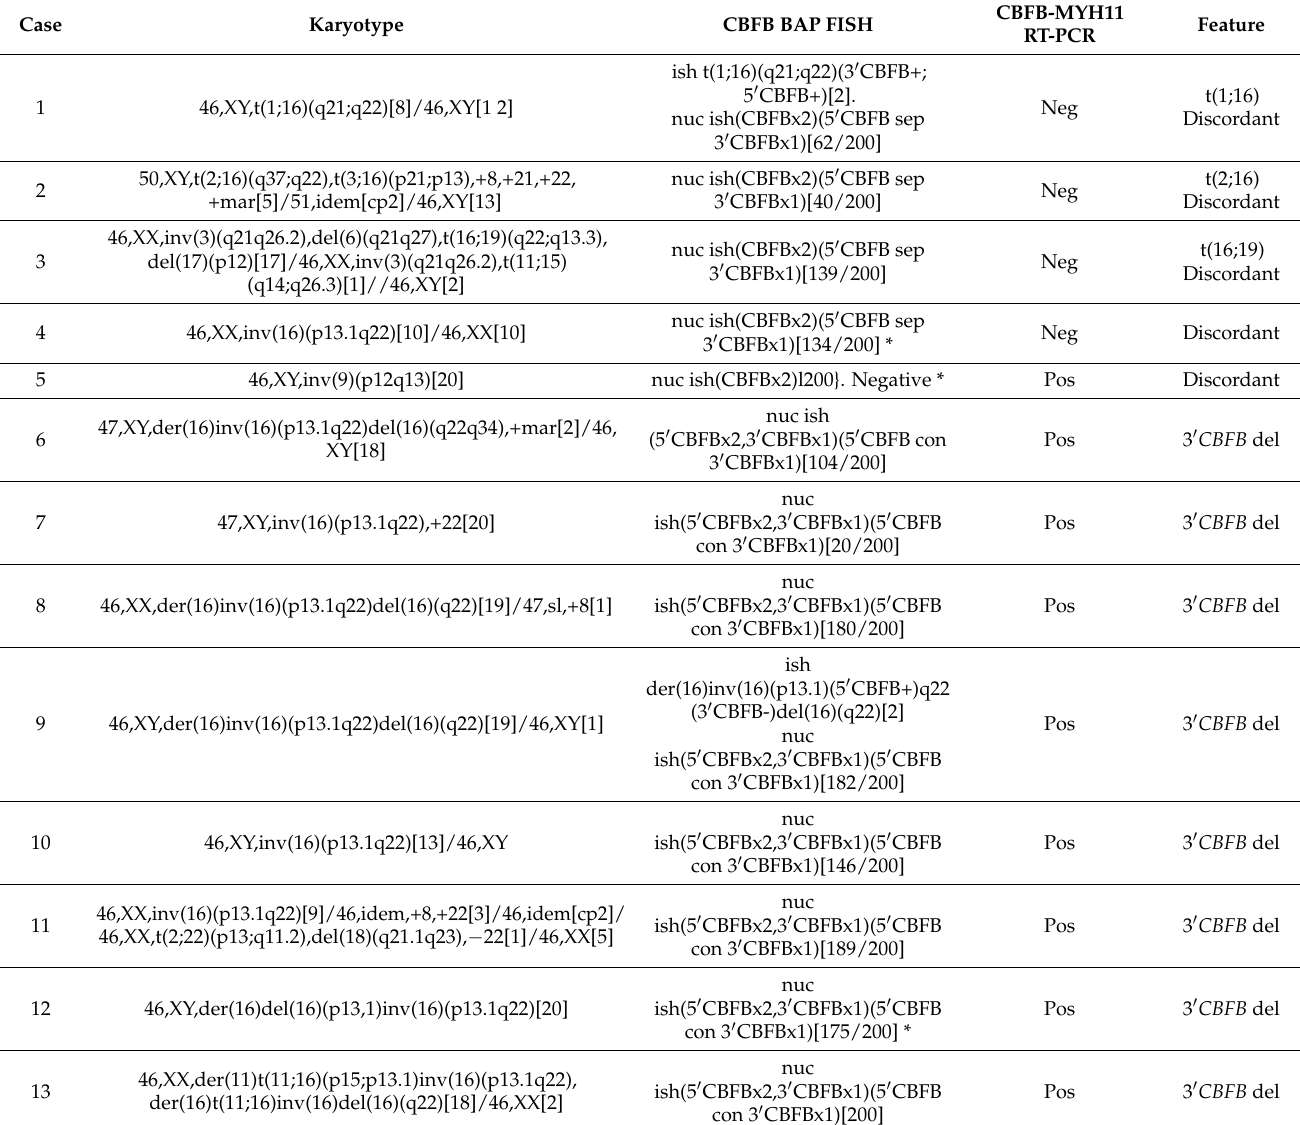
Table 3. Summary of 17 representative cases with discordant CBFB BAP FISH and CBFB-MYH11 RT-PCR results (cases #1–#5) and cases with atypical FISH